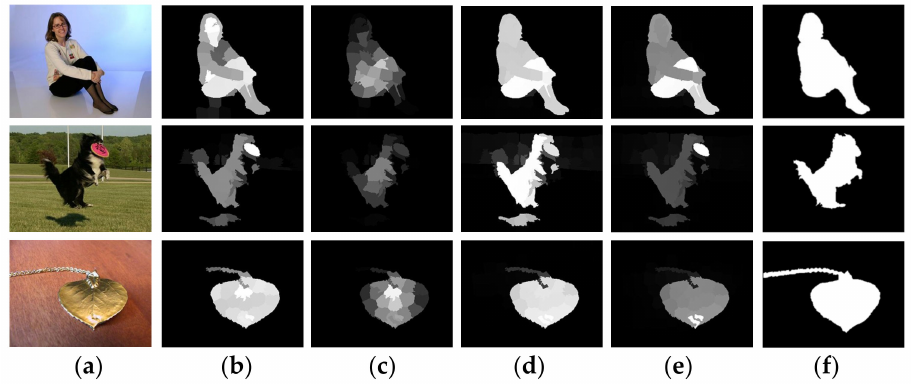
Figure 6. Main phases of compactness-based saliency calculation. ( a ) Original images. ( b ) Initial compactness-based saliency maps. ( c ) Saliency maps after compactness-biased Gaussian model. ( d ) Saliency maps after the proposed diffusion process. ( e ) Saliency maps after diffusion on 2-layer sparse graph. ( f ) Ground